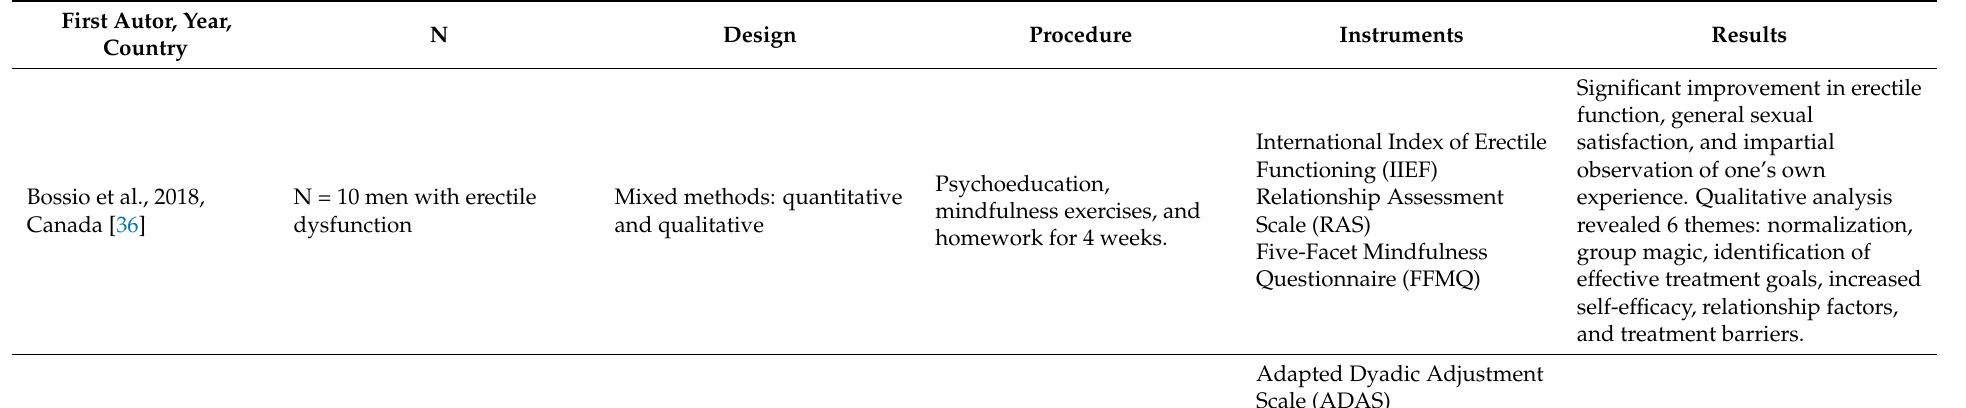
Table 1. Mindfulness-based interventions in men and selected data